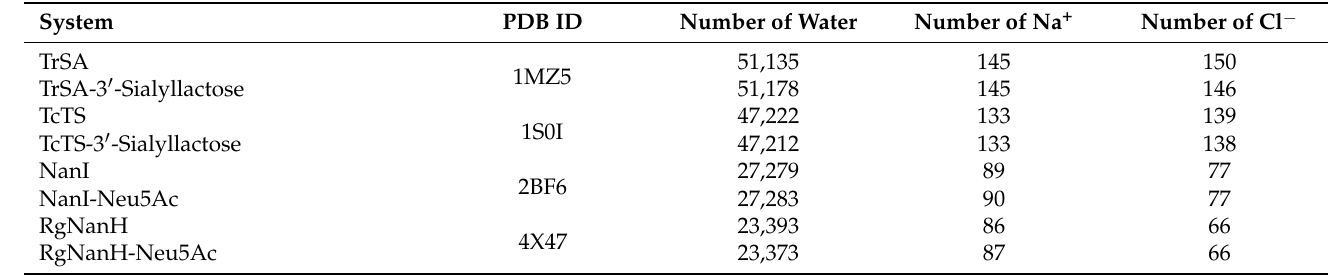
Table 1. Detailed information of molecular dynamics simulation